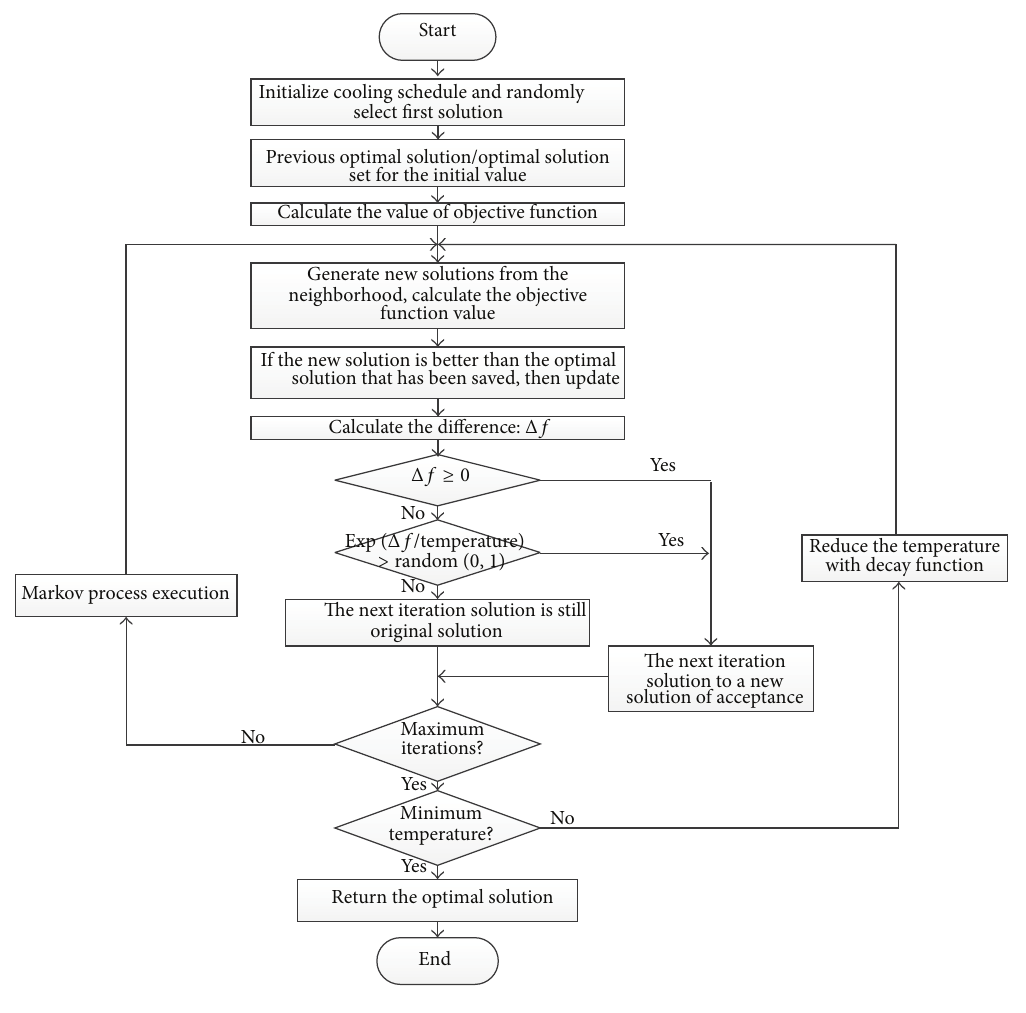
Figure 1: Item generation flow